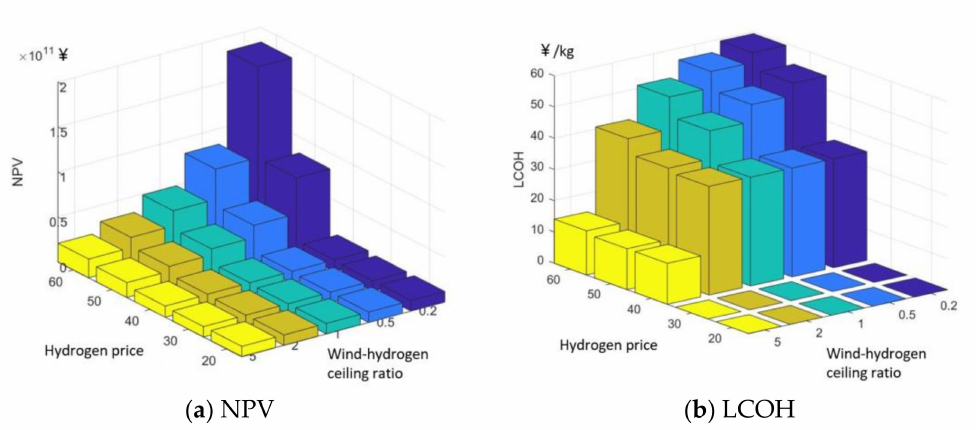
Figure 4. Case study for Anhui province (analysis method focusing on regions with NPV as optimi‑ sation